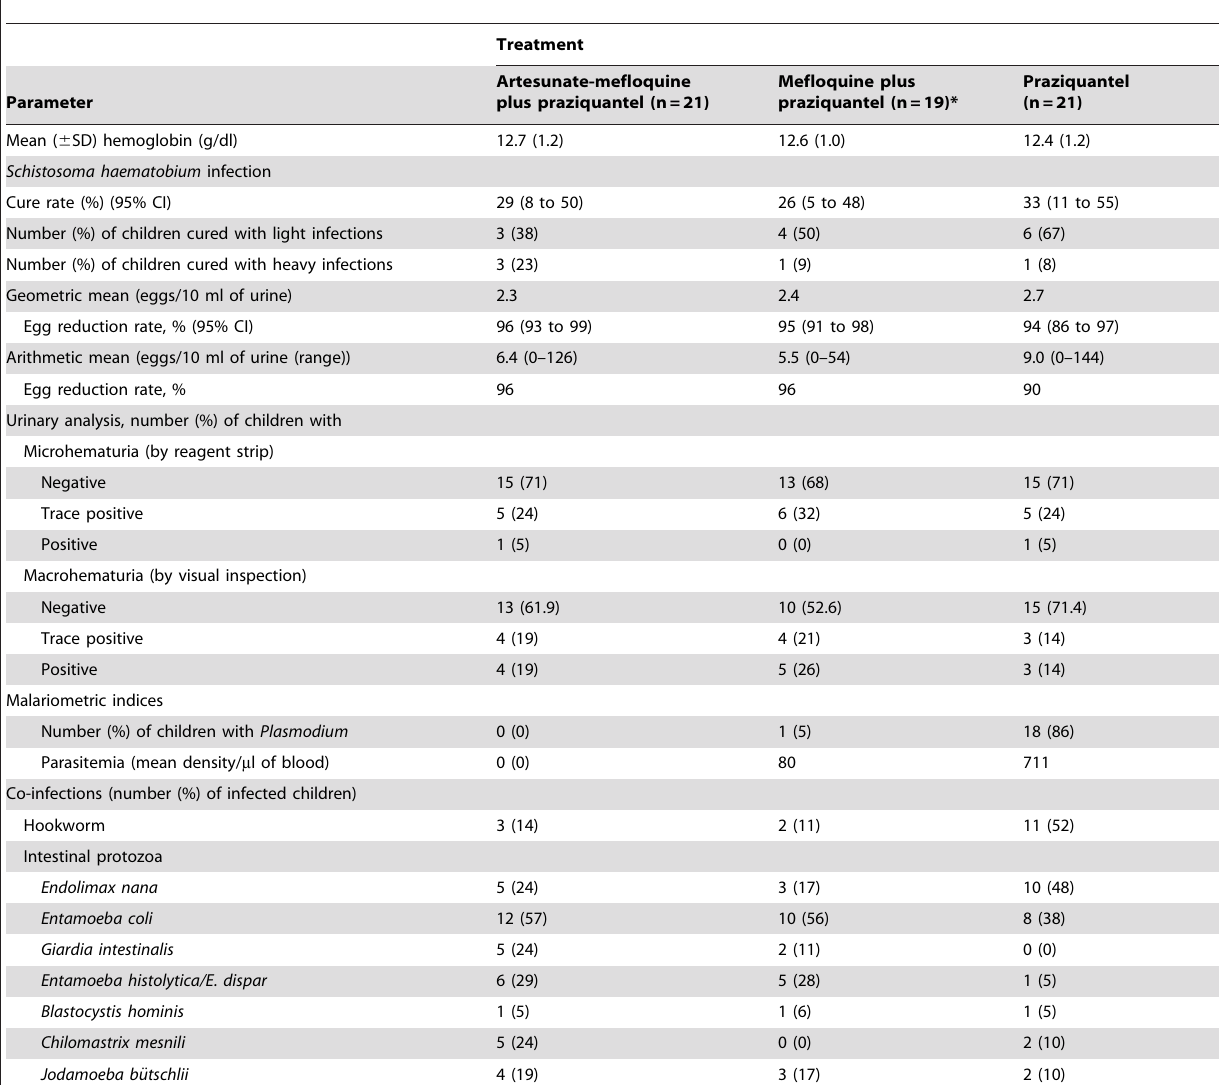
Table 2. Effect of artesunate-mefloquine plus praziquantel, mefloquine plus praziquantel, and praziquantel on S. haematobium and concomitant co-infections at the first treatment